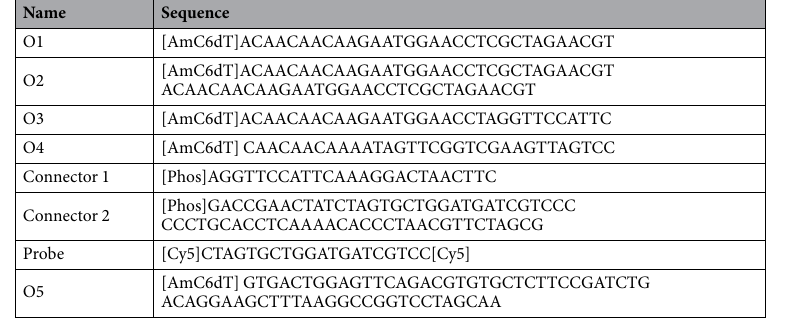
Table 1. Oligonucleotides